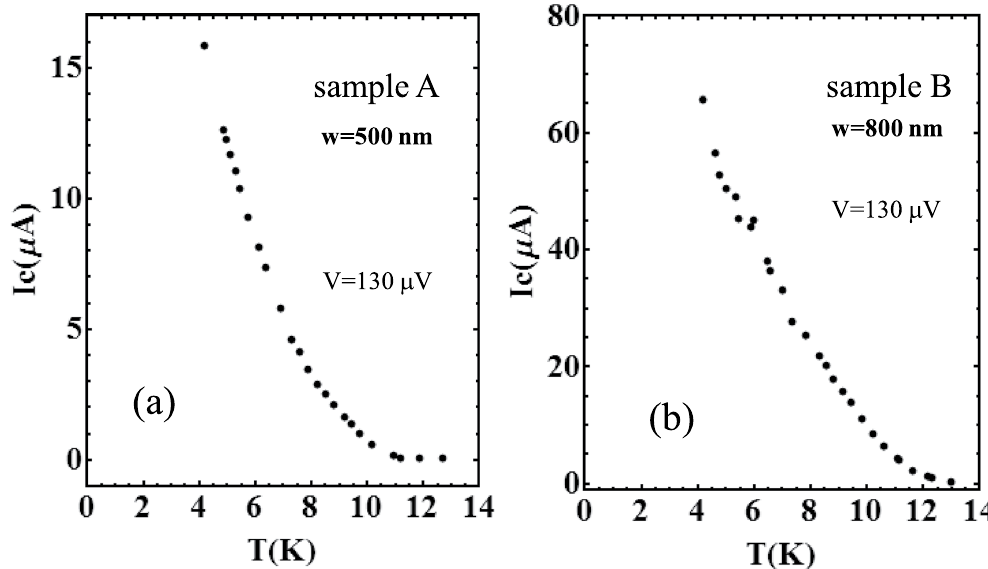
Figure 3. Temperature dependence of the critical current I c (the current at which the voltage across the nanostrip overcomes the threshold V = 130 μ V) for ( a ), sample A and ( b ), sample